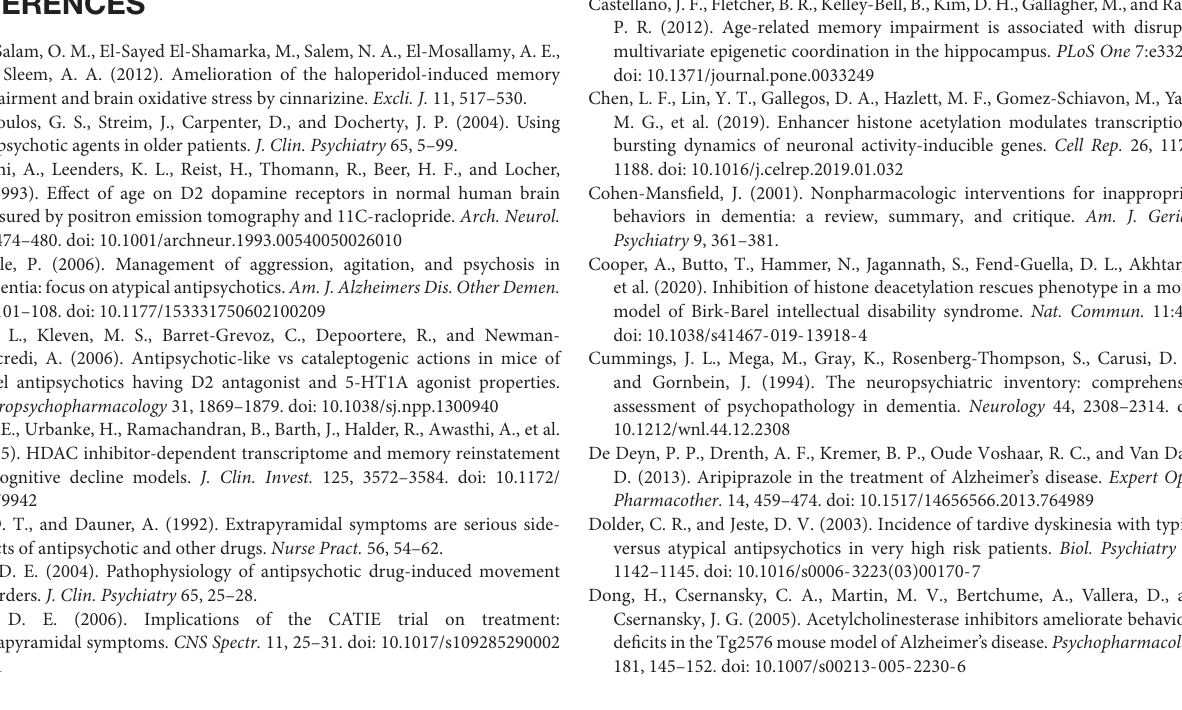
Supplementary Figure 1 | Schematic of Experimental Procedure. Young and aged mice were treated with VEH, HAL, CI-994 + HAL, or CI-994 alone for 14 days. Behavioral tests were completed during days 8–13 with order: Novel object recognition (NOR, day 9–11), rotarod (day 12), and catalepsy (day 13).